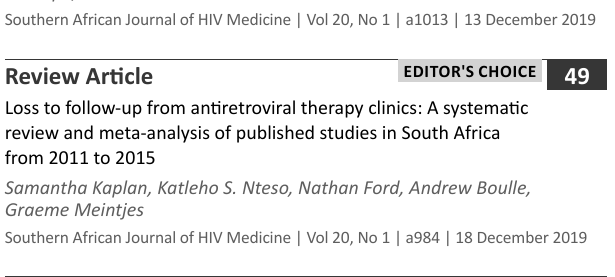
Rapid emergence of resistance to antiretroviral treatment after undisclosed prior exposure: A case report